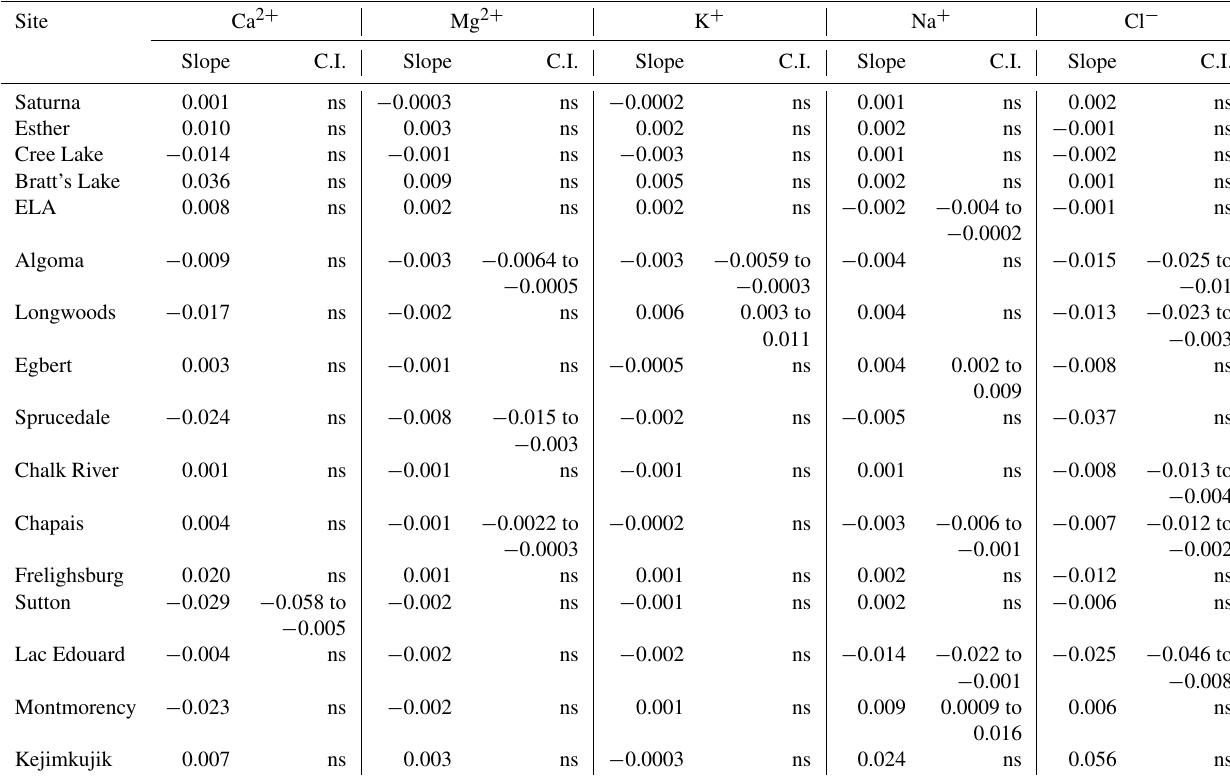
Table 3. Rate of change in annual wet deposition of Ca 2 + , Mg 2 + , K + , Na + , and Cl − . Slope refers to the Sen’s slope (kgha − 1 a − 1 ) ; C.I. refers to the 90% confidence interval of the slope; ns indicates no significant